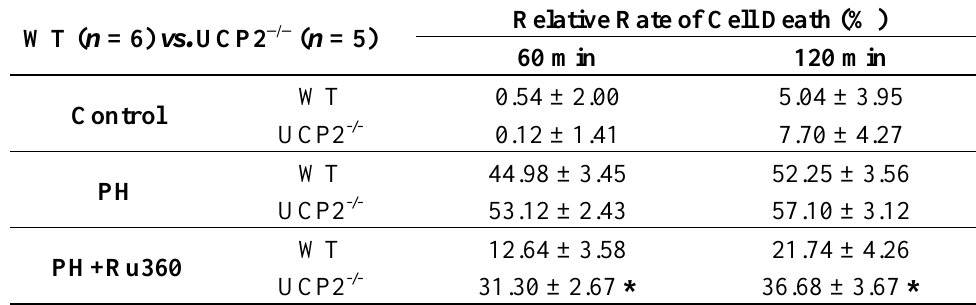
Table 3. Relative rate of cell